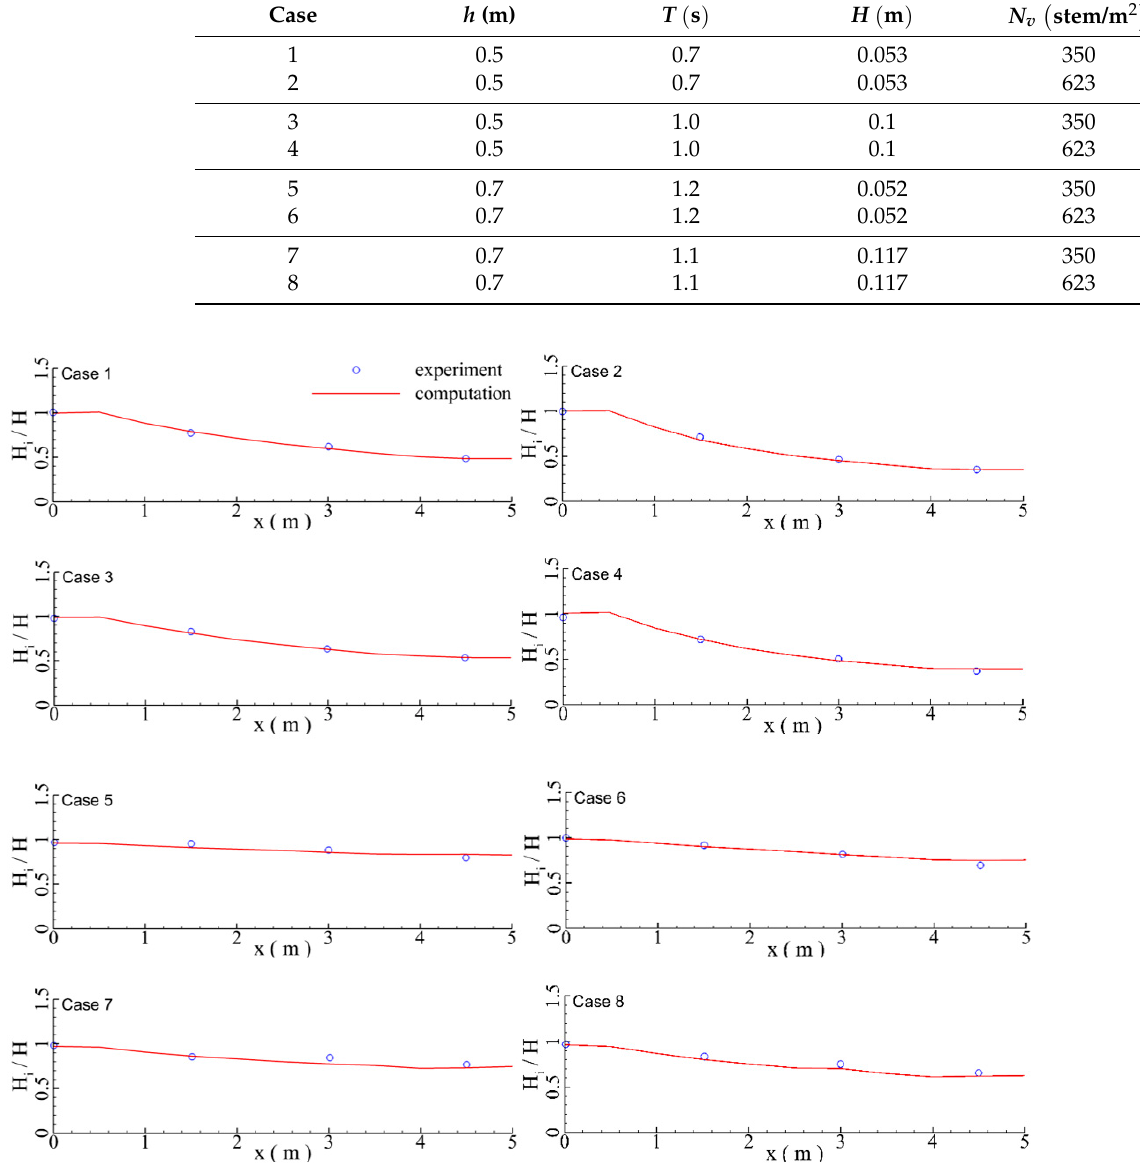
Figure 5. Spatial distributions of the averaged wave heights under different parameter setups as listed in Table 1.